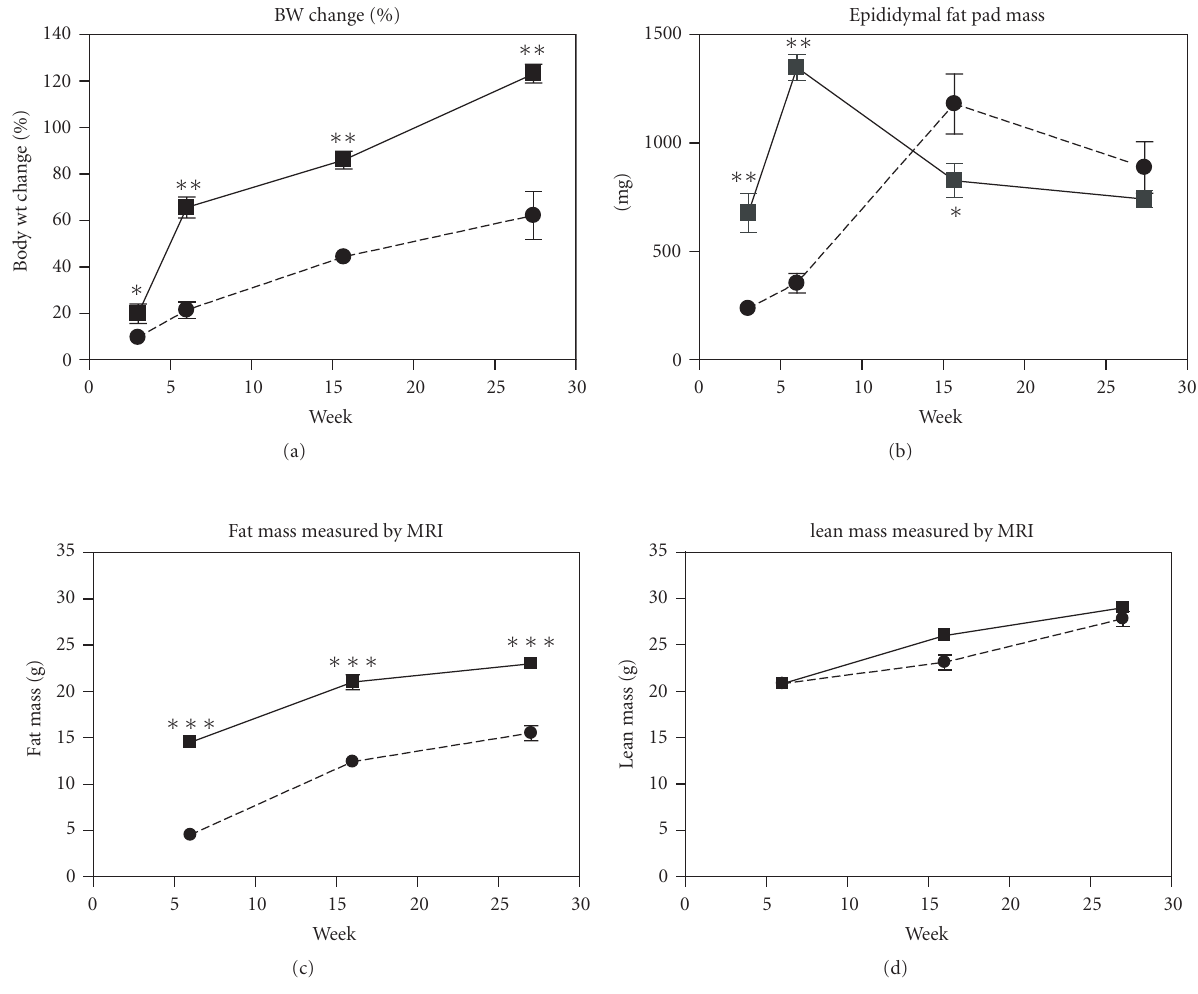
Figure 1: An HF/CH diet kinetically induced metabolic obesity. C57BL/6 mice were placed on Chow (circles and dashed lines) or a diet of 45% fat and 0.12% cholesterol (squares and solid line) for 3, 6, 16, or 27-weeks. Groups of n ≥ 7 were sacrificed at each time point for both chow and HF/CH diets. Body weight (a), mg of epididymal fat (b), total fat (c), and lean (d) mass were all measured. Epididymal fat tissue and blood from these animals were subsequently used for FACs analysis. Values represent the mean and SEM. Unpaired T test was used to compare Chow to DIO (HF/CH diet cohort) at each time point; ∗ P < . 05, ∗∗ P < . 001, and ∗∗∗ P < . 0001.